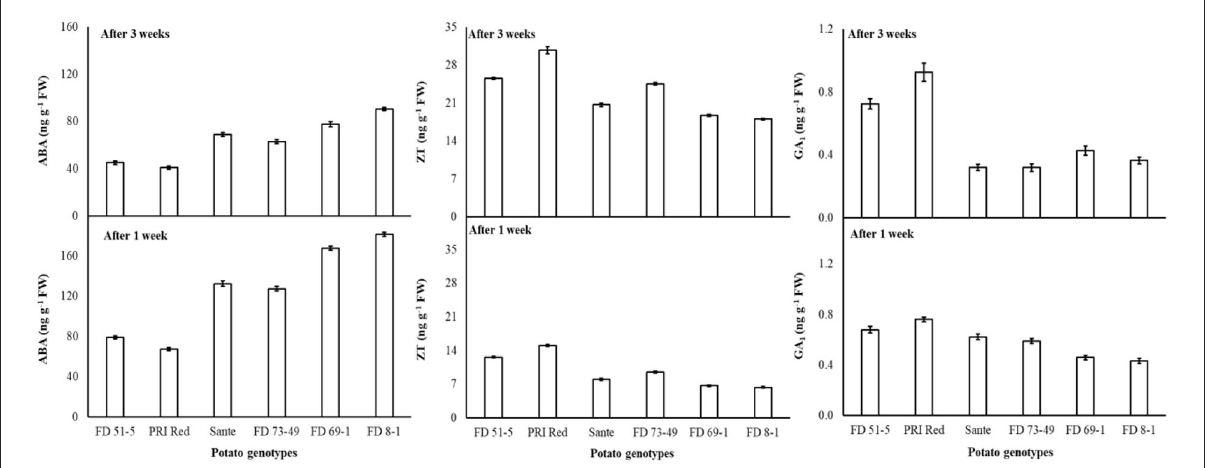
FIGURE2 Change in ABA, ZT, and GA 1 levels in tuber during storage period (3 weeks) following treatment with alone benzylaminopurine and gibberellic acid. Vertical error bars represent standard error of means (n: 4).